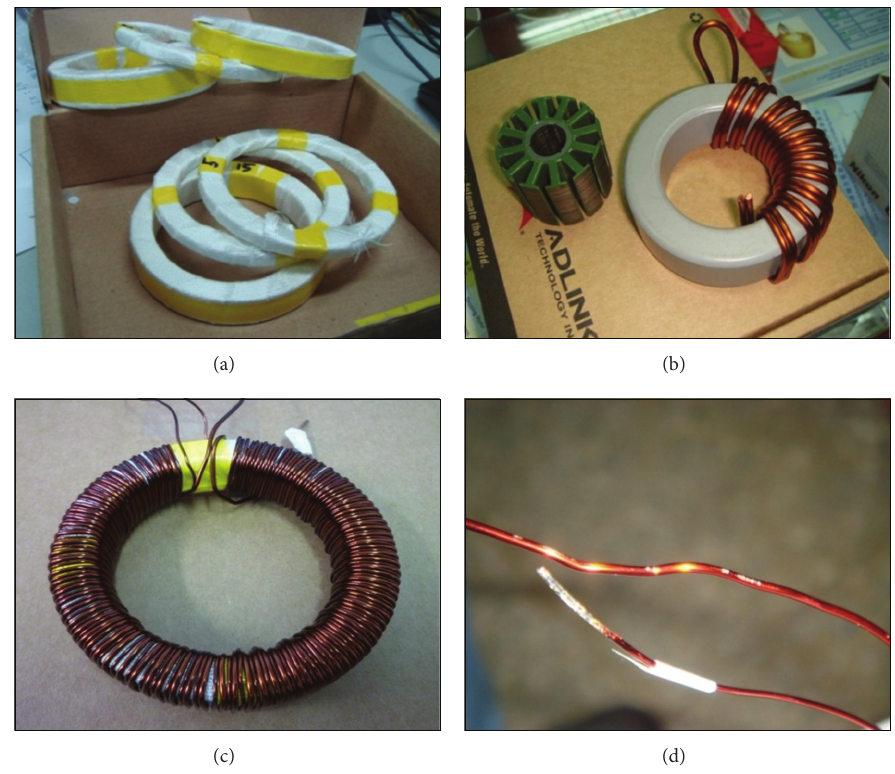
Figure 1: Four subfigures of toroidal laminated silicon-steel sheets used as the control setup in the experiments. (a) Silicon-steel sheets wrapped with glass fiber tape. (b) Sample of a coated toroidal coil. (c) Traditional toroidal transformer used as the control setup in the experiments. (d) Damage to enamel-insulated copper wire that could cause a short